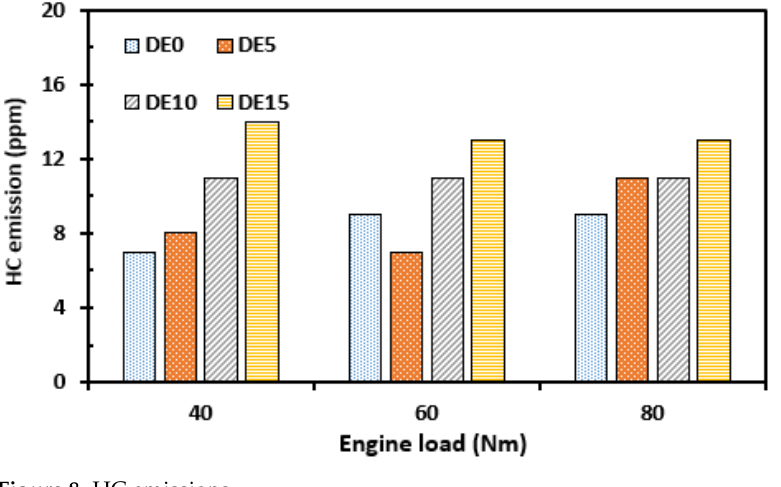
Figure 8. HC emissions.